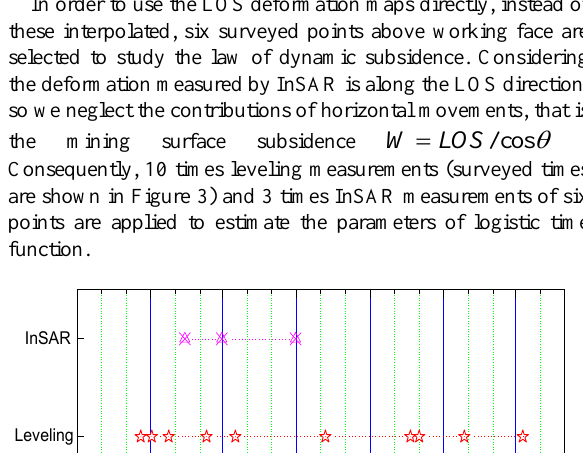
Figure 2. Differential interferograms (Up) and accumulated LOS deformation maps (Bottom) of investigated area. The black lines denote designed working face, and the green, blue and cyan line denotes the advance location in January 13, February 28 and May 31, 2010, respectively.